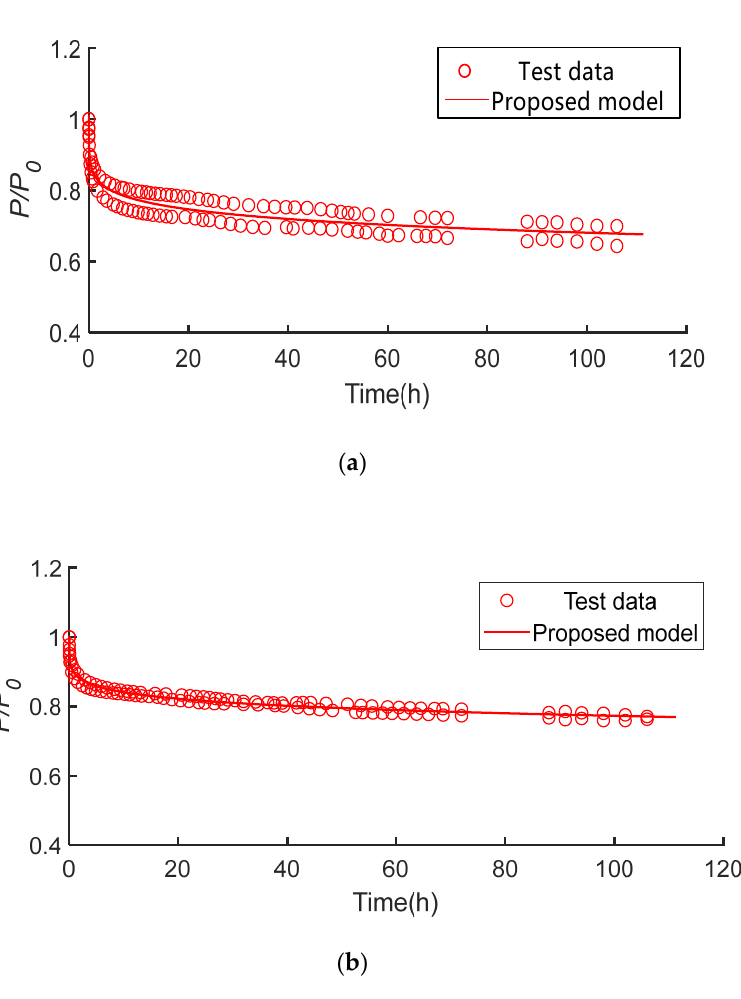
Figure 18. Proposed model for stress relaxation. ( a ) TX Series; ( b ) TY Series. As depicted in Figure 19, the loss of PF-HSB in TX Series reaches 65% when the corrosion rate is 15.56%, while the loss of PF-HSB in TY Series reaches 80% when the corrosion rate is 17.17%.